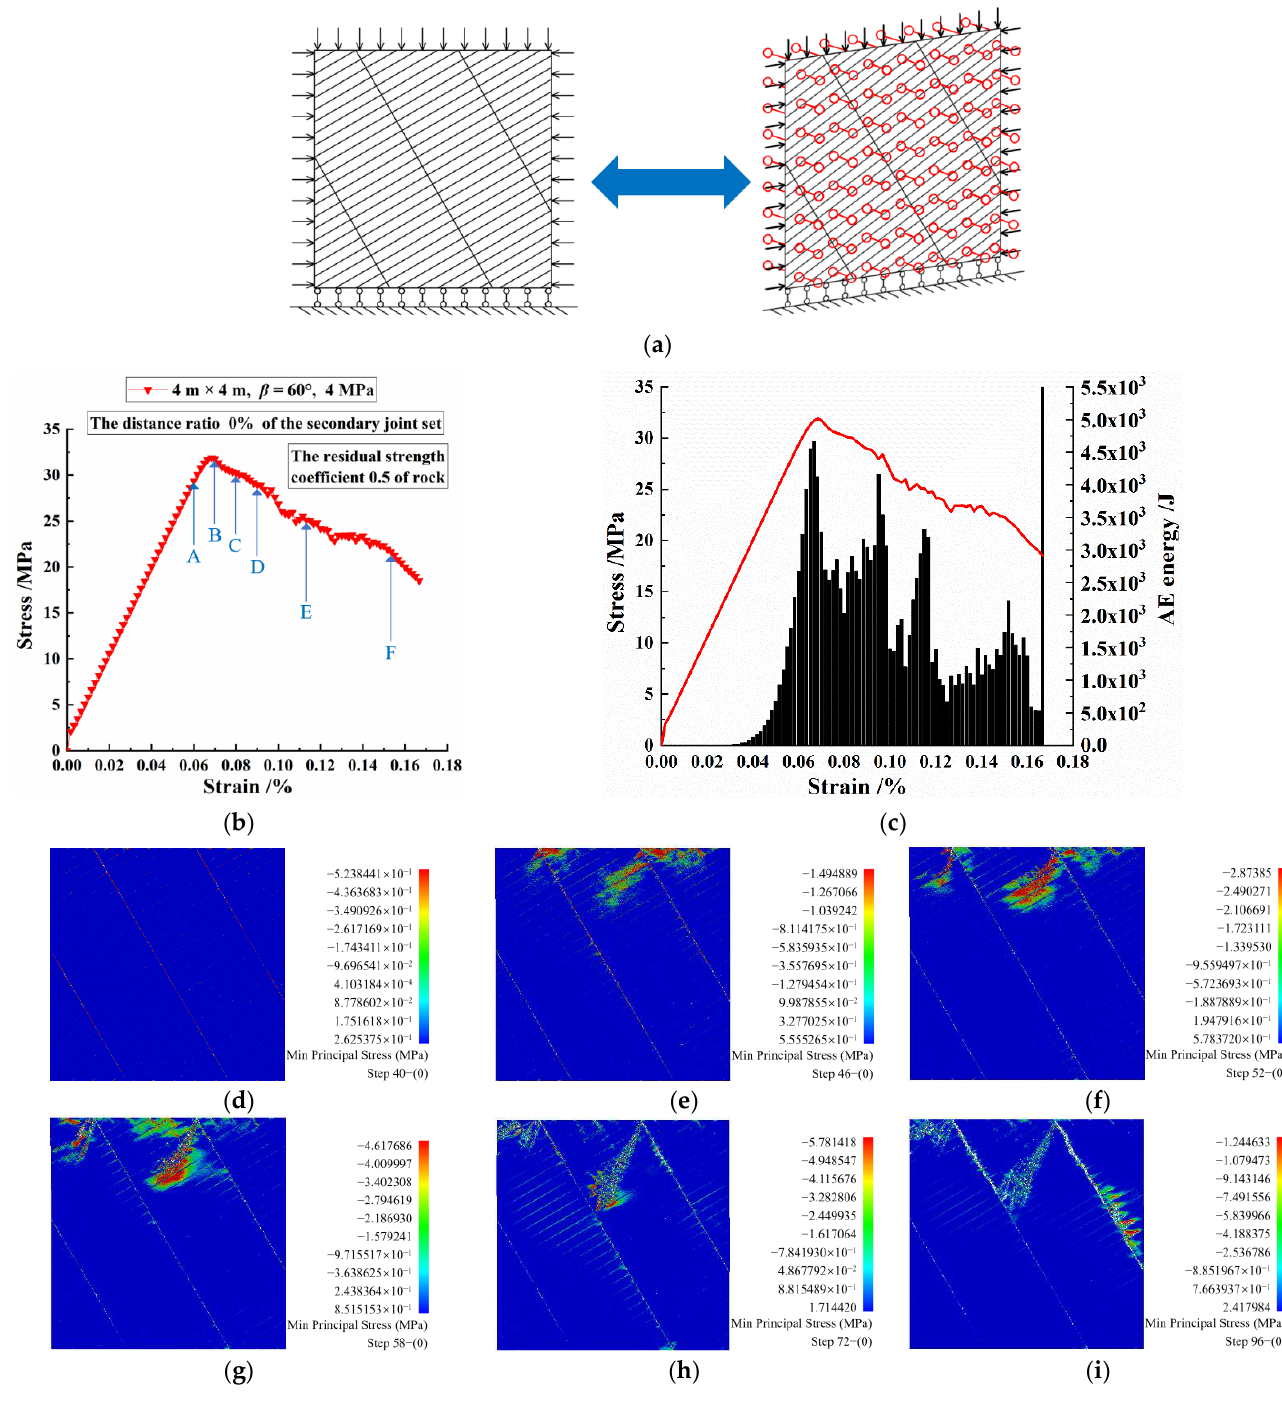
Figure 12. ( a ) Under plane strain, the schematic diagram of the CJBs model with β = 60° and the joint distance ratio 0%; ( b , c ) the loading curve and AE energy; ( d – i ) the minor principal stress contours at the Points A~F.